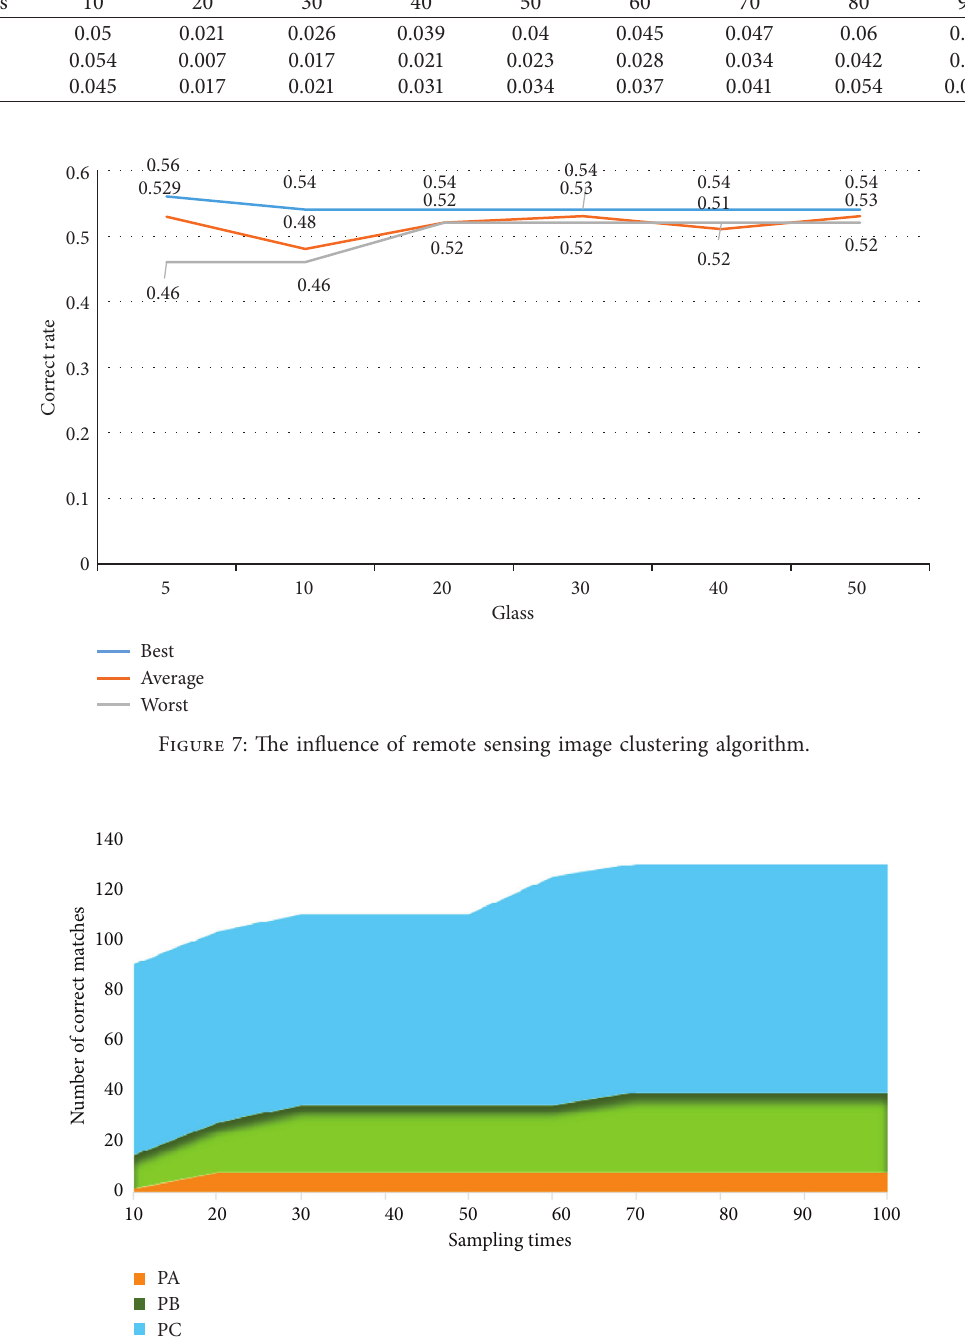
Figure 8: The relationship between the number of sampling times of the algorithm RANSAC and the correct matching point pair and running